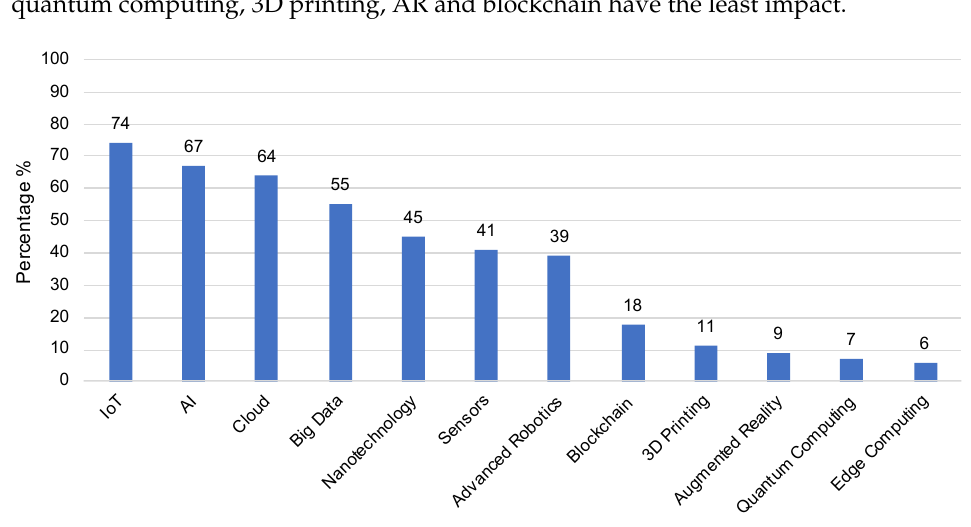
Figure 18. Global Industries Prediction on Technology Impact ( n = 1802)